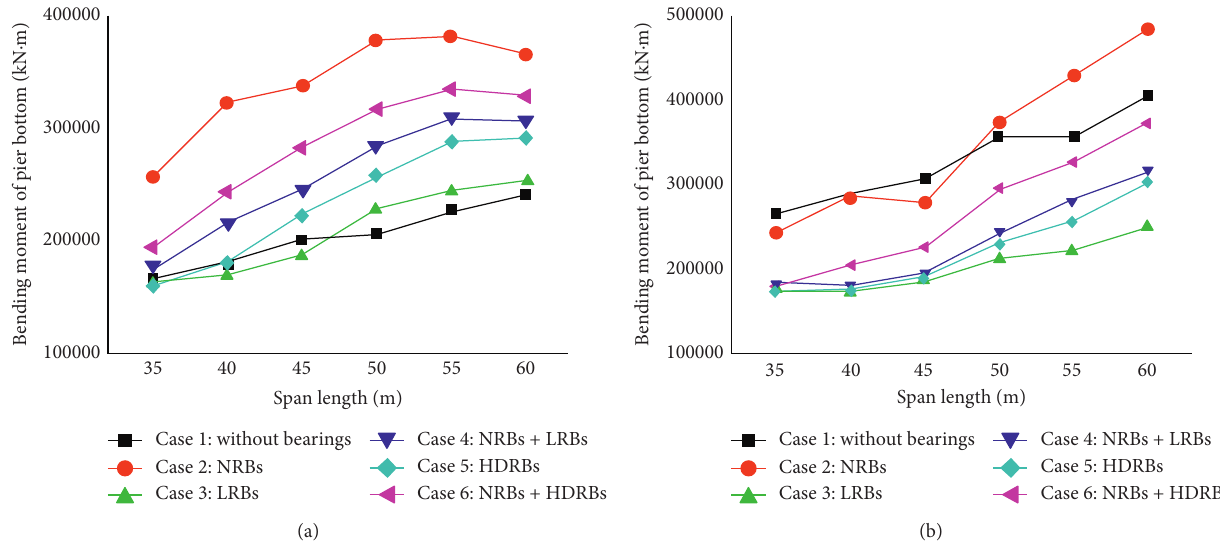
Figure 17: Bottom bending moment of the pier with the change of span length in different cases: (a) longitudinal; (b)